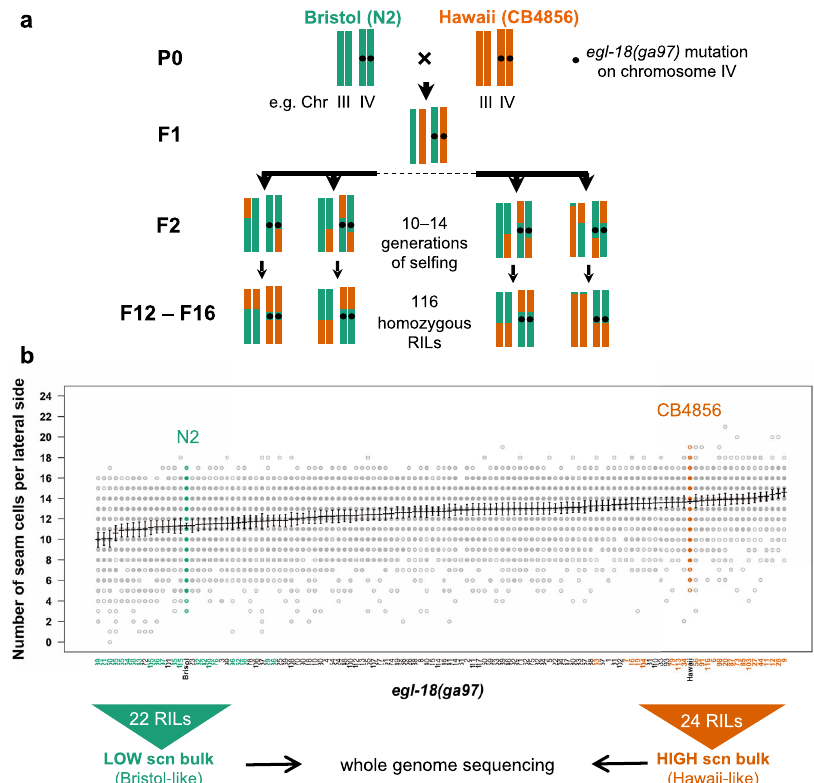
Fig. 2 Generation and phenotypic analysis of recombinant inbred lines. a Generation of RILs between CB4856 and N2 carrying the egl-18(ga97) mutation. Two chromosomes (III and IV) are shown for simpli fi cation. b Seam cell number quanti fi cation in 116 recombinant inbred lines, ranked from lowest to highest average seam cell number. Parental strains are shown in green (N2) and orange (CB4856). The two extremes (low-bulk and high bulk) of the phenotypic distribution were pooled for whole-genome sequencing. Error bars indicate average SCN ± 95% con fi dence intervals, n = 77 independent animals for RIL95, n = 80 for all other RILs and n = 520 independent animals for the N2 and CB4856